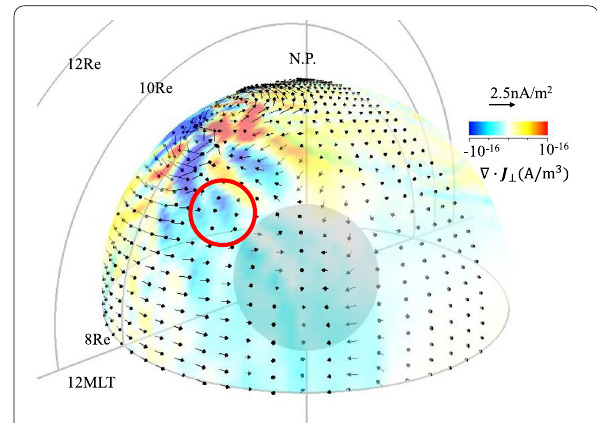
Fig. 9 FPC vectors in the post-noon sector on the sphere of r in the northern hemisphere at 5.9 min. ∇ ⊥ · J ⊥ on this sphere is shown with color shading. The red circle indicates the region through which the type L current system from B H passes (Fig.